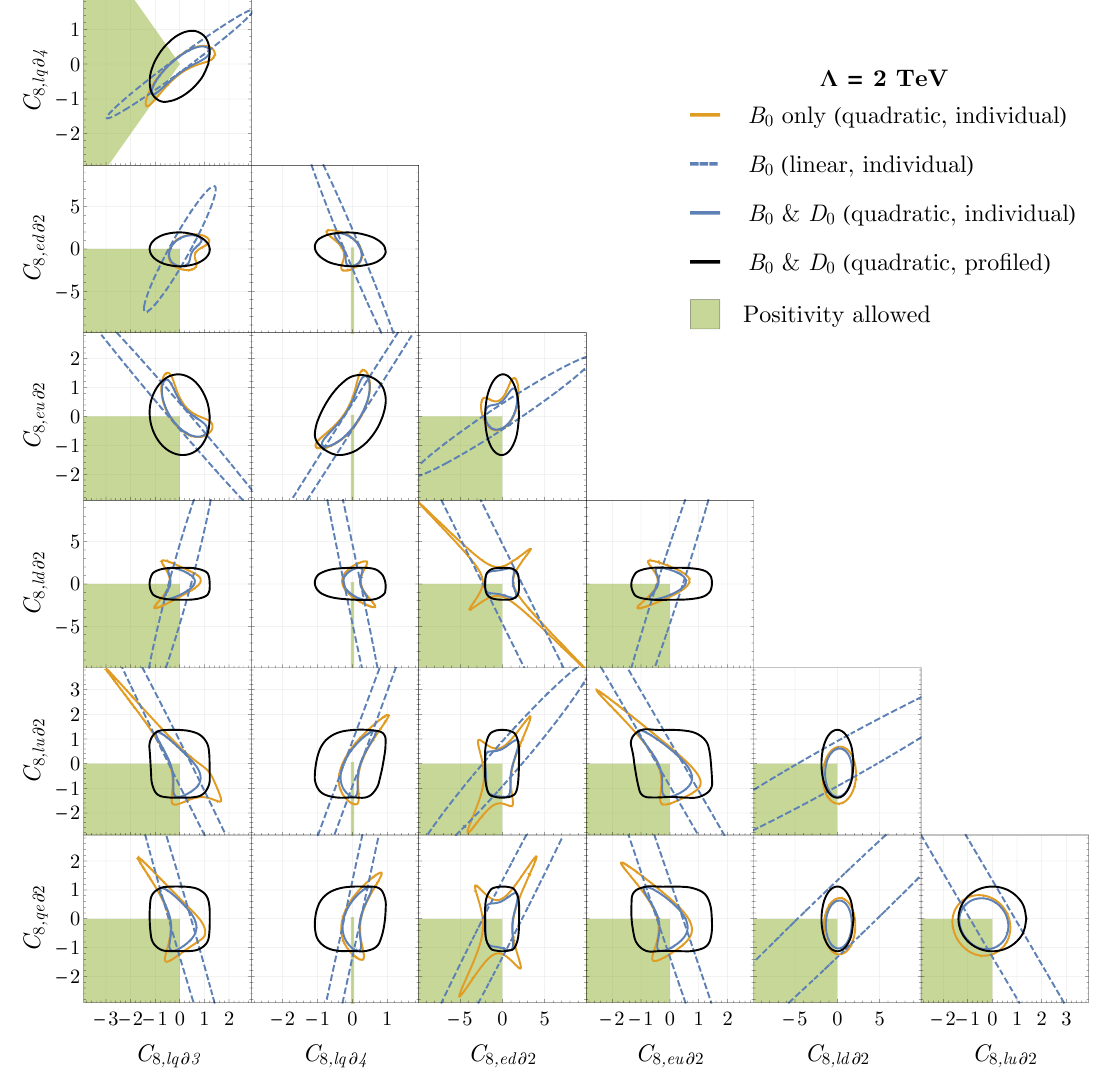
Figure 4 . Two-dimensional individual, 95% confidence regions in the dimension-8 coefficient space using the double-differential distributions of the B 0 and D 0 angular moments. The elastic positivity bounds of table 1 are shaded in